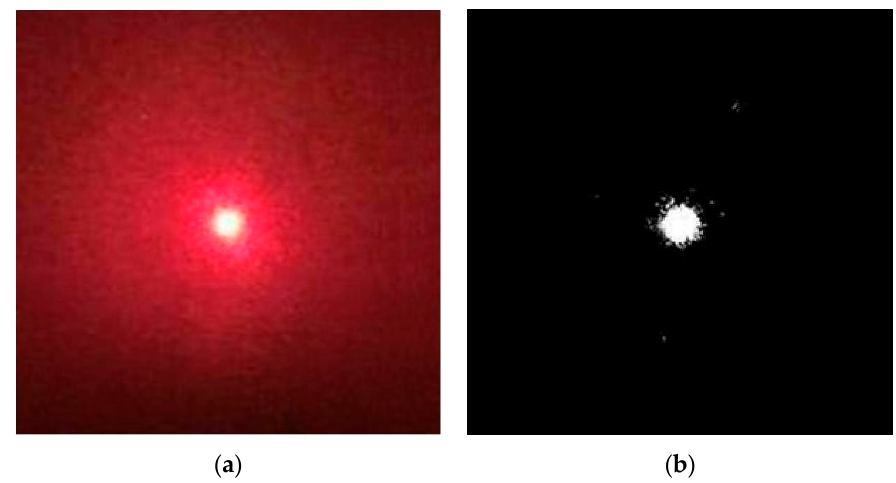
Figure 2. Original spot image acquired through the experiment. ( a ) Real spot image. ( b ) Binarized spot image.